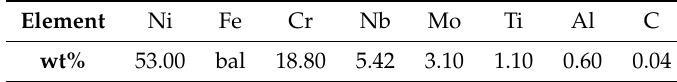
Table 1. Nominal chemical composition of GA Alloy 718